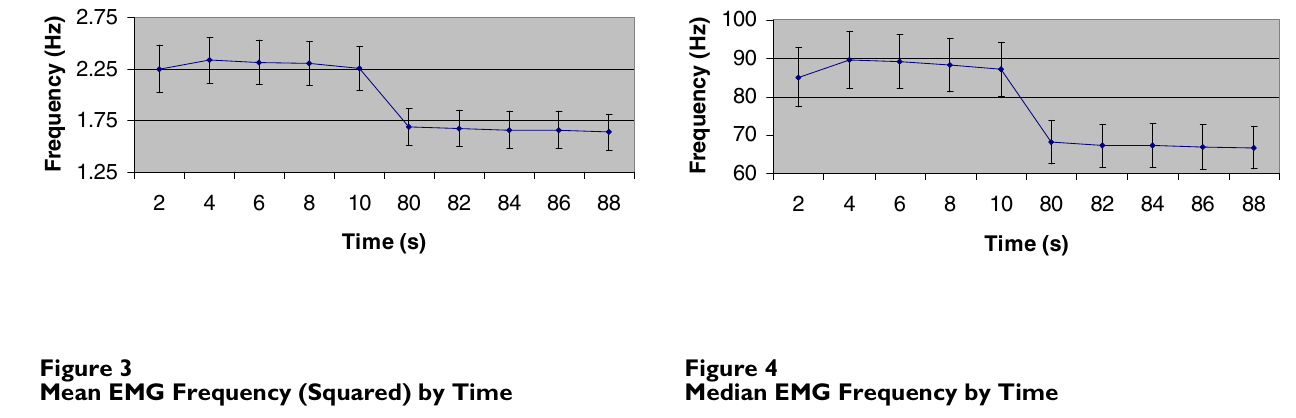
Median EMG Frequency by